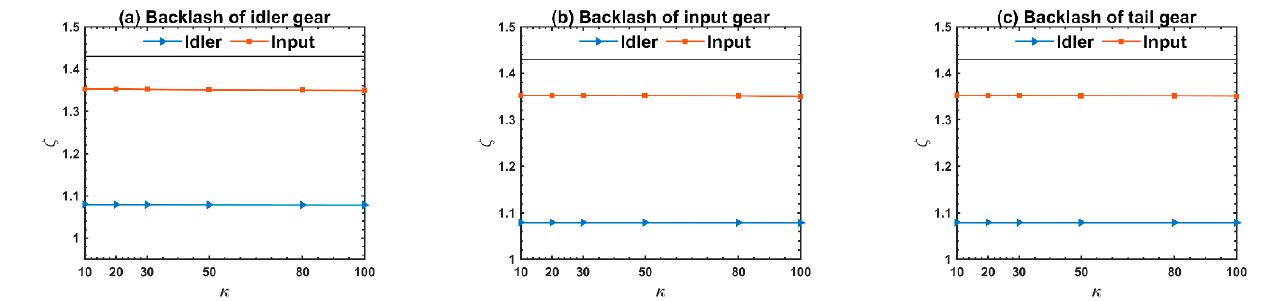
Figure 19. Influence of the backlash on the load-sharing